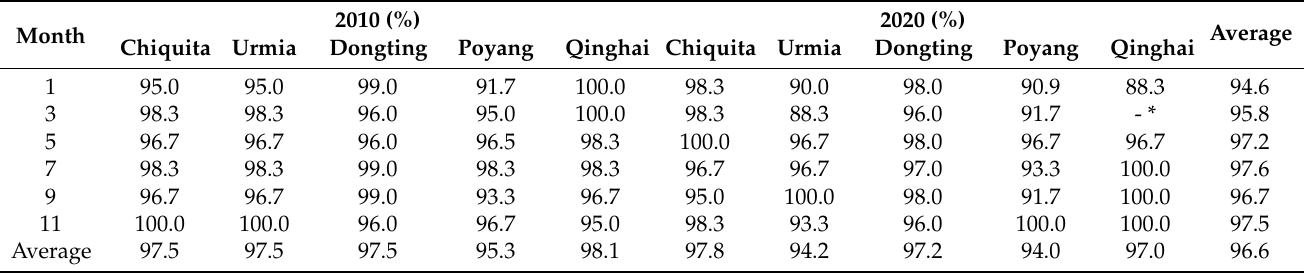
Table 4. Results of overall accuracies (OA) of surface water extractions by